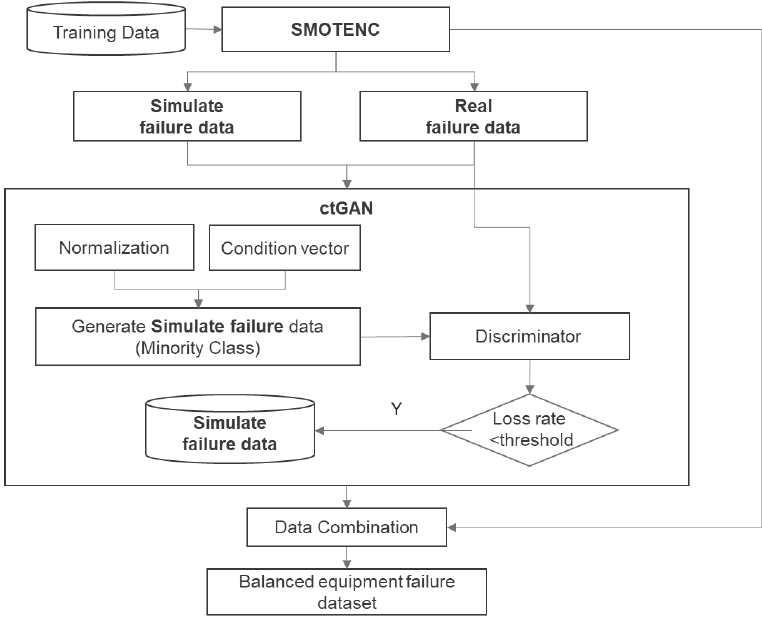
Figure 2. Limit Data Generating Process.